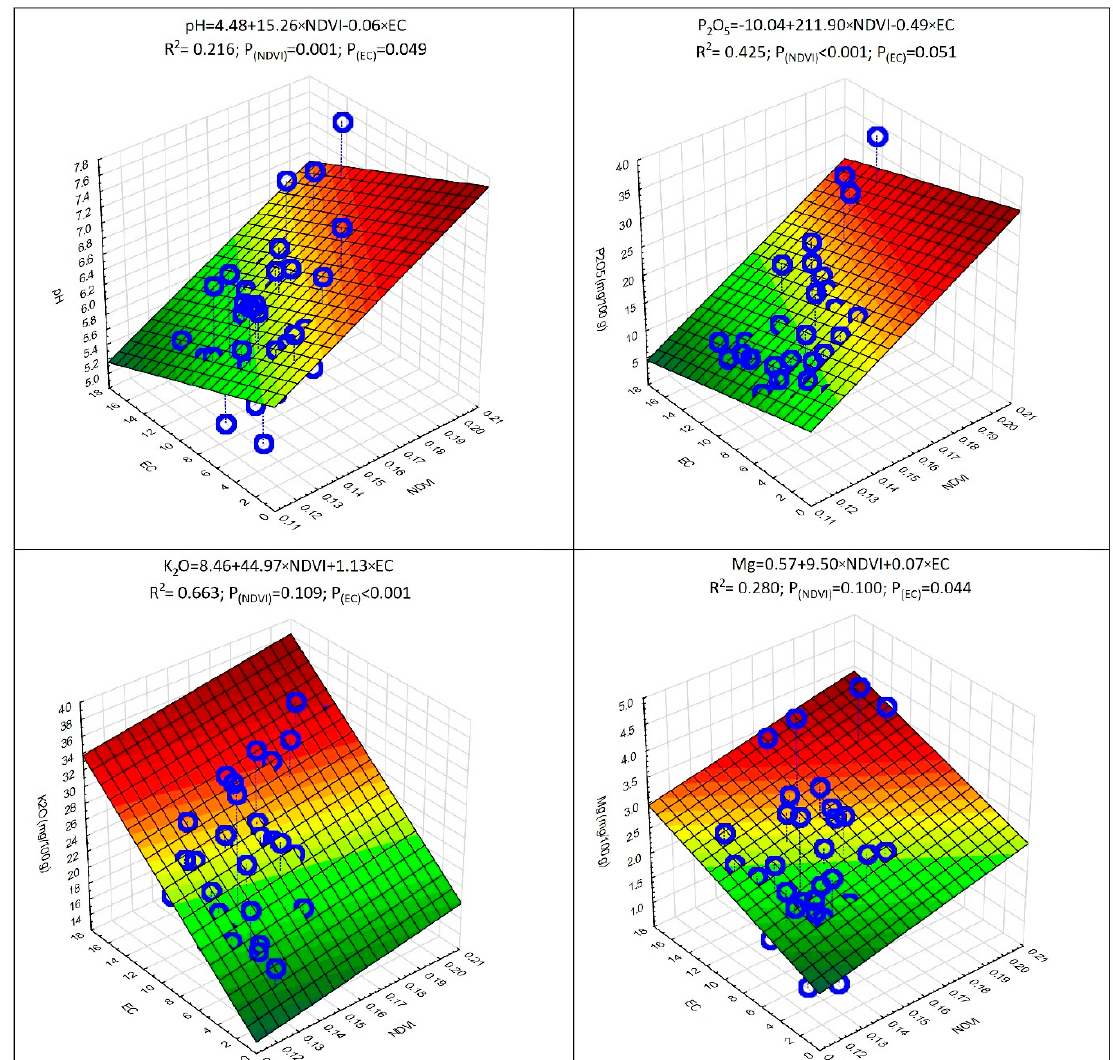
Figure 6. The relationship between soil EC and NDVI (at 09/05/2021) and pH and nutrient content in soil evaluated using multiple linear regression.